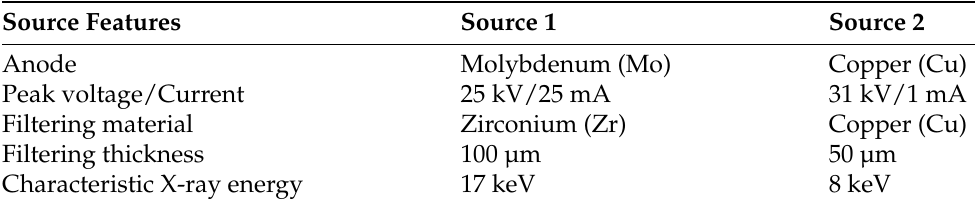
Table 1. Characteristics of the X-ray sources used.